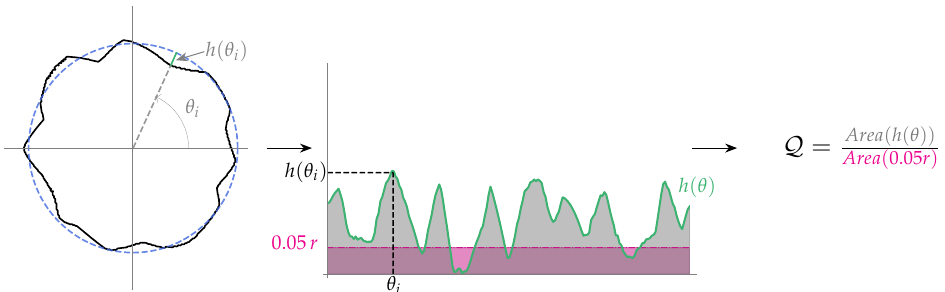
Figure 11. Distribution of the differences and the areas ratio. In “green”, the difference between shape and the ideal circle can be appreciated, while in “pink”, the difference between the ideal circle and the increased one is